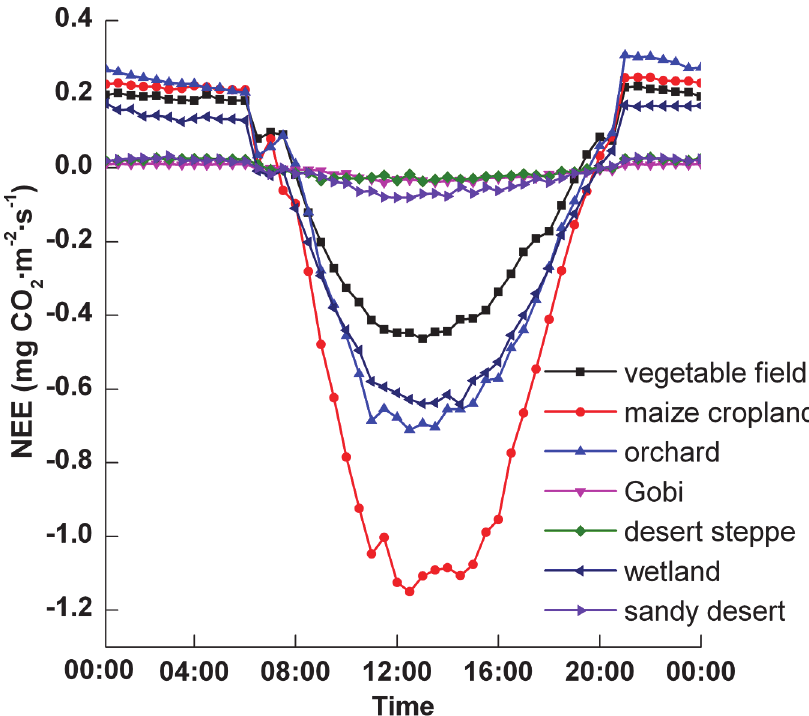
Fig 2. Diurnal variations of NEE in different